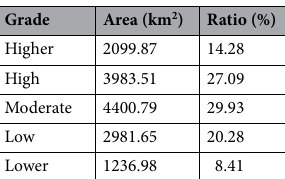
Table 3. Stability grade of disaster-pregnant environment and its influence